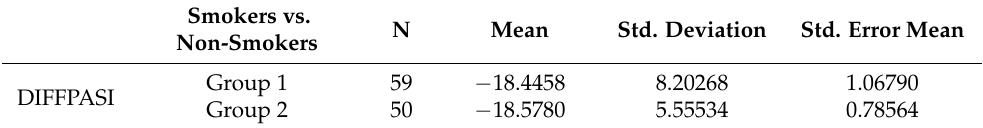
Table 1. DIFFPASI in group